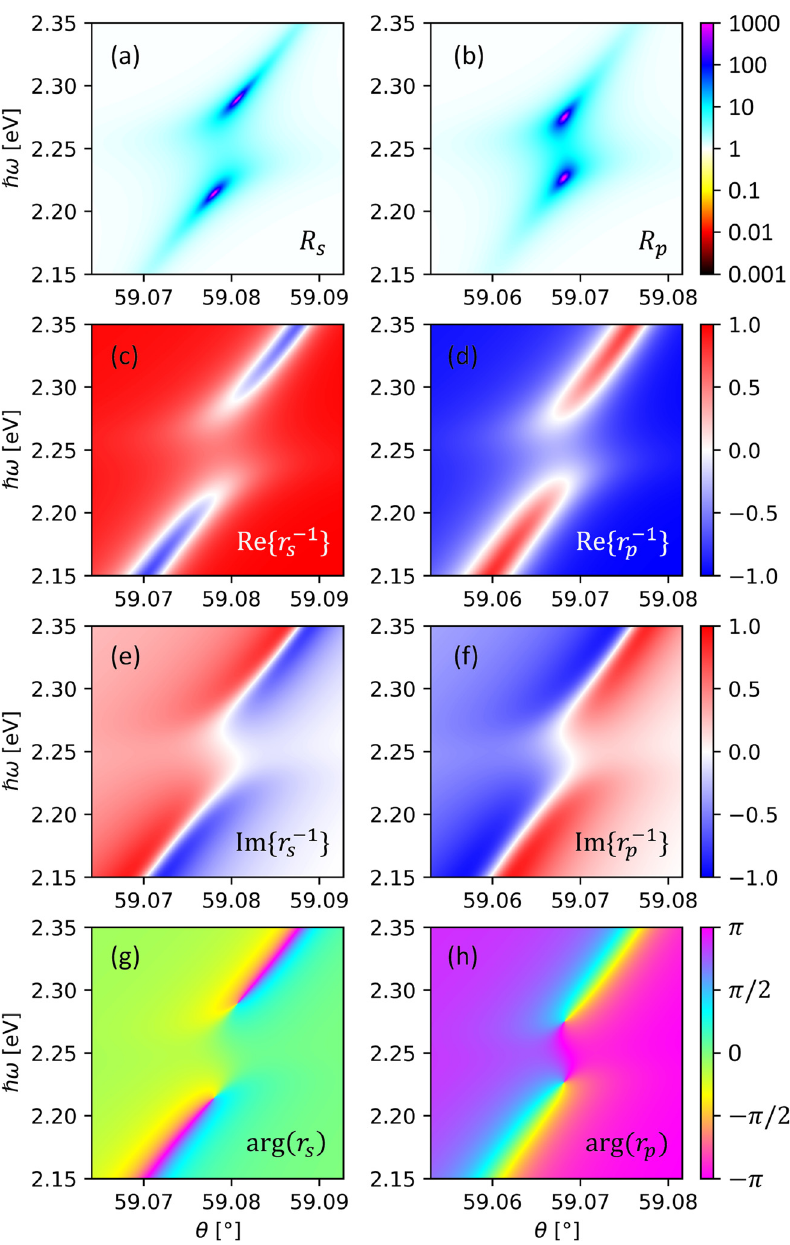
Figure 7: Results of the transfer matrix calculations, showing the amplified reflection just above the critical angle ( θ cr = 59.00 ° ) resulting from evanescent coupling of incident light to the guided modessupportedbythegain-dopedlayeras a function of the incidence angle θ and fre- quency ω , assuming h = 80 nm ( ε l ≈ ε g ), prism index of 1.75, and prism-to-slab dis- tance of 2000 nm. (a, b) Re fl ectivity R for the s- and p-polarized incident light. (c – f) Dis- tributionoftherealandtheimaginarypartof r − 1 (inverse of the re fl ection coef fi cient). The intersections of the real and the imaginary zeros create pairs of singularities, similar to those observed in Figure 4. (g, h) Pairs of phase vortices with topological charge ± 1 coincide with the singularities in (a, b), just like in Figure opposedtosimple metasurfacesina symmetric host[53],the proposed asymmetric multilayer geometry can also support phase singularities in the lossy regime, which is shown in Figure 8 (analogous to Figure 5). In case of a lossy wave- guide, phase singularities become points of perfect ab- sorption (zero in R , and lack of T due to evanescence), similar to those reported in the study by Berkhout and Koenderink [42]. From the above results, we conclude that the singular scattering response of weakly scattering and amplifying metasurfaces is not due to their periodic patterning per se .